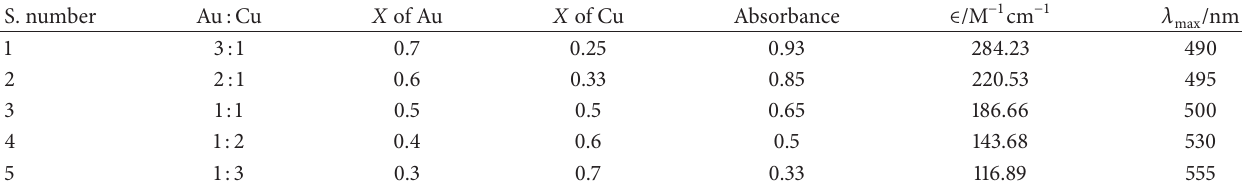
Table 3: UV-Visible spectral characteristics of Au-Cu alloy nanoparticles in different ratios.